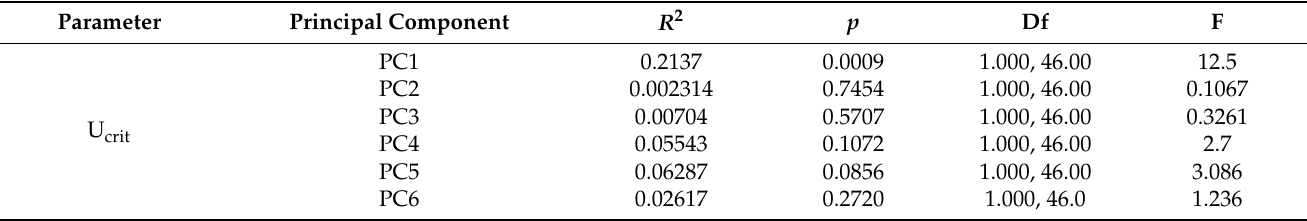
Table A3. Linear regressions of PC by measurements of aerobic swimming performance of grass carp in the lotic